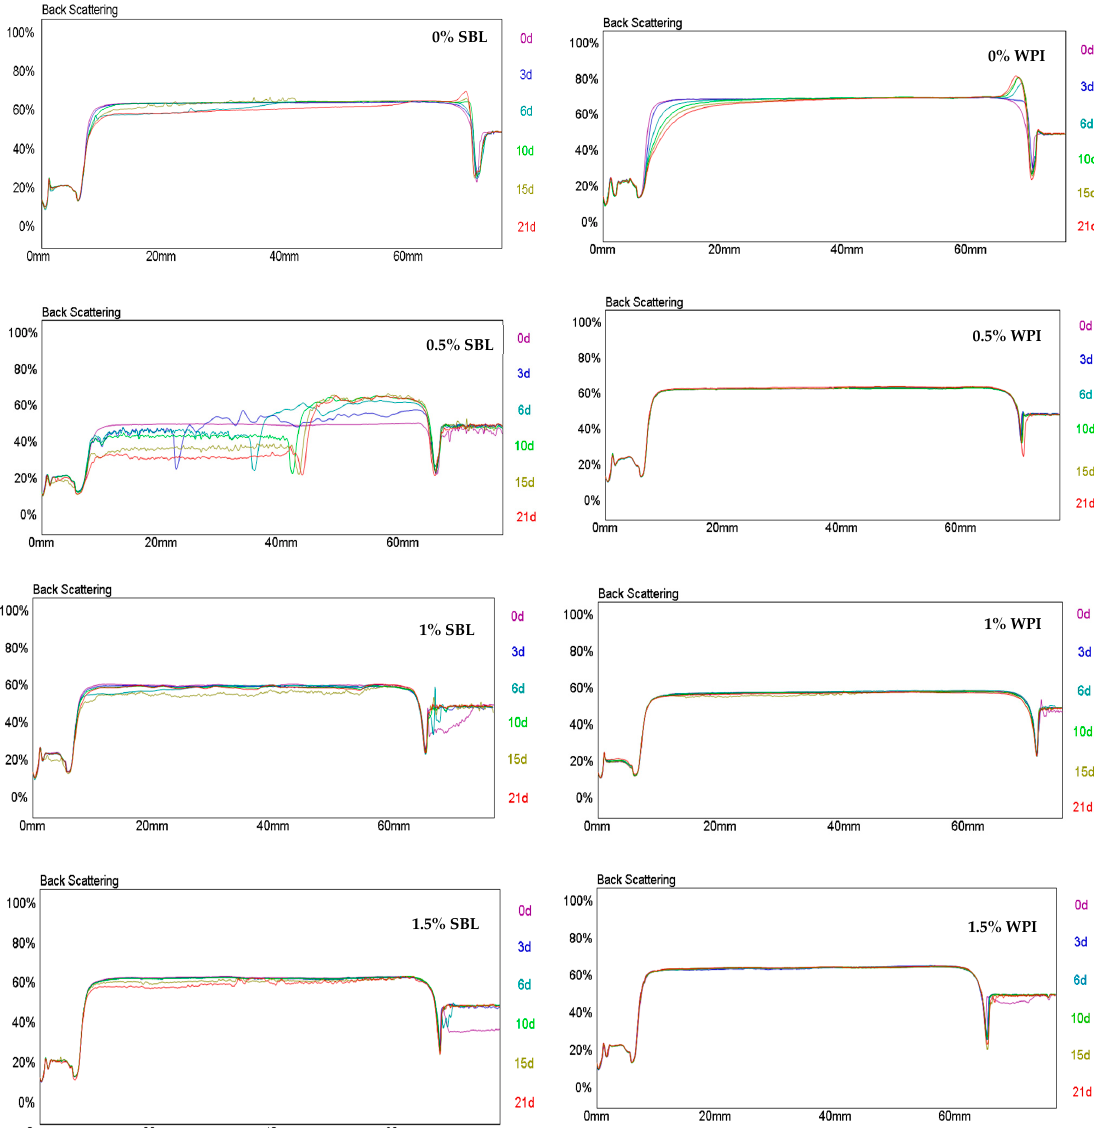
Figure 3. Variations on the backscattering profile of curcumin-loaded nanoemulsions stabilized with soybean lecithin (SBL) or whey protein isolate (WPI) and different sodium alginate concentrations (0, 0.5, 1 and 1.5%) during 21 days at 4 °C.